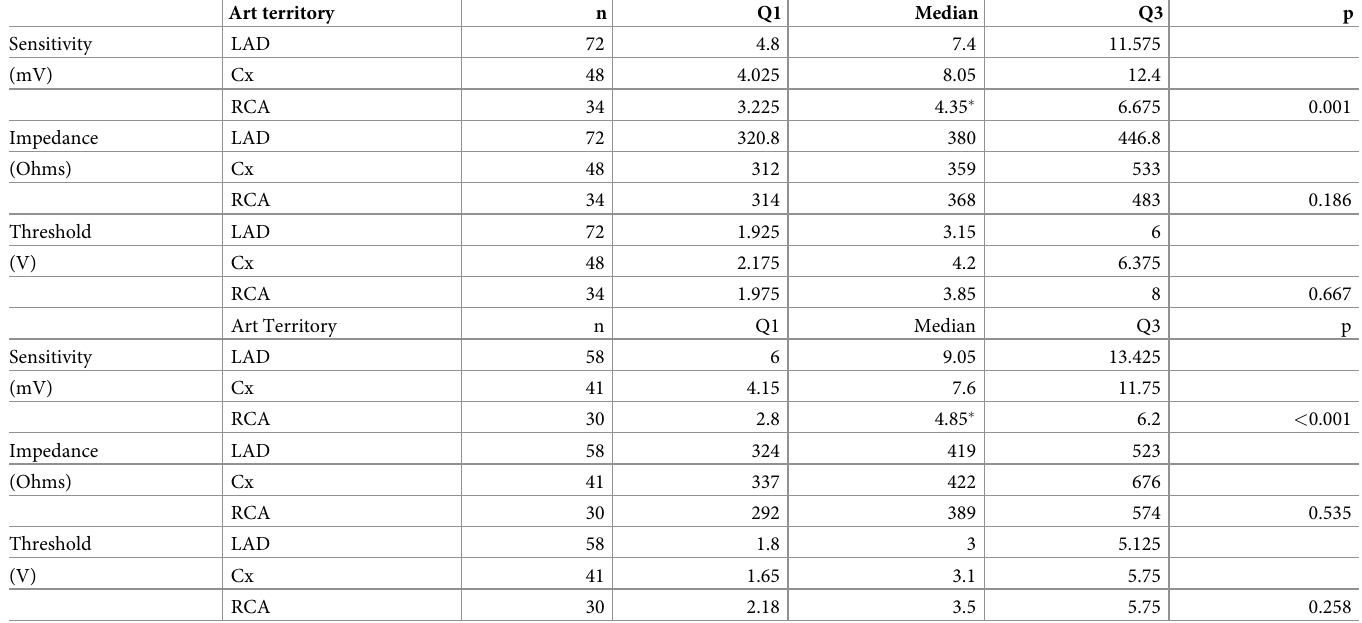
Table 2. A. Electrophysiological parameters of normal segments in elective patients with stable angina. A significant reduction in sensitivity was seen in the right cor- onary artery (RCA) territory compared to the left anterior descending (LAD) and circumflex (Cx) territories (p = 0.001). B. Electrophysiological parameters of normal seg- ments in acute patients hospitalised with NSTEMI. A significant reduction in sensitivity was seen in the RCA territory compared to the LAD and Cx territories (p = <